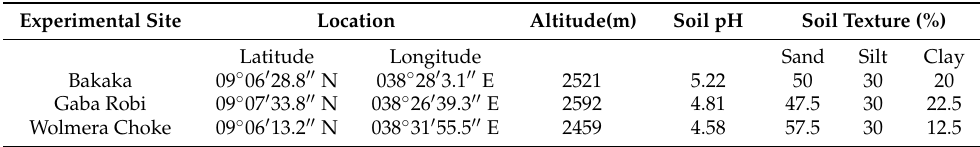
Table 1. Description of experimental